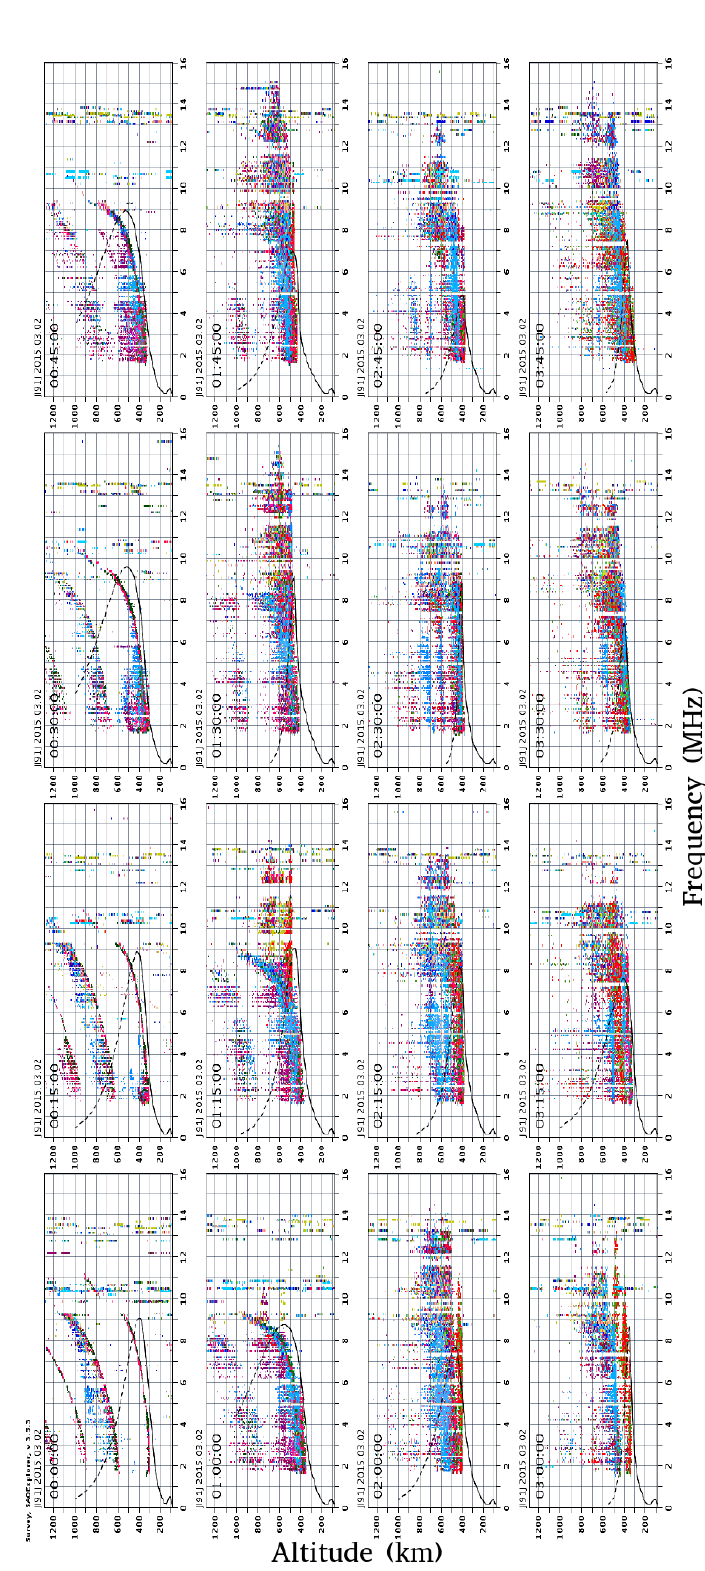
Figure 5. Ionograms showing the occurrence of ESF on 2 March 2015 between 00:15 and 03:45UT. The local time zone of these events was